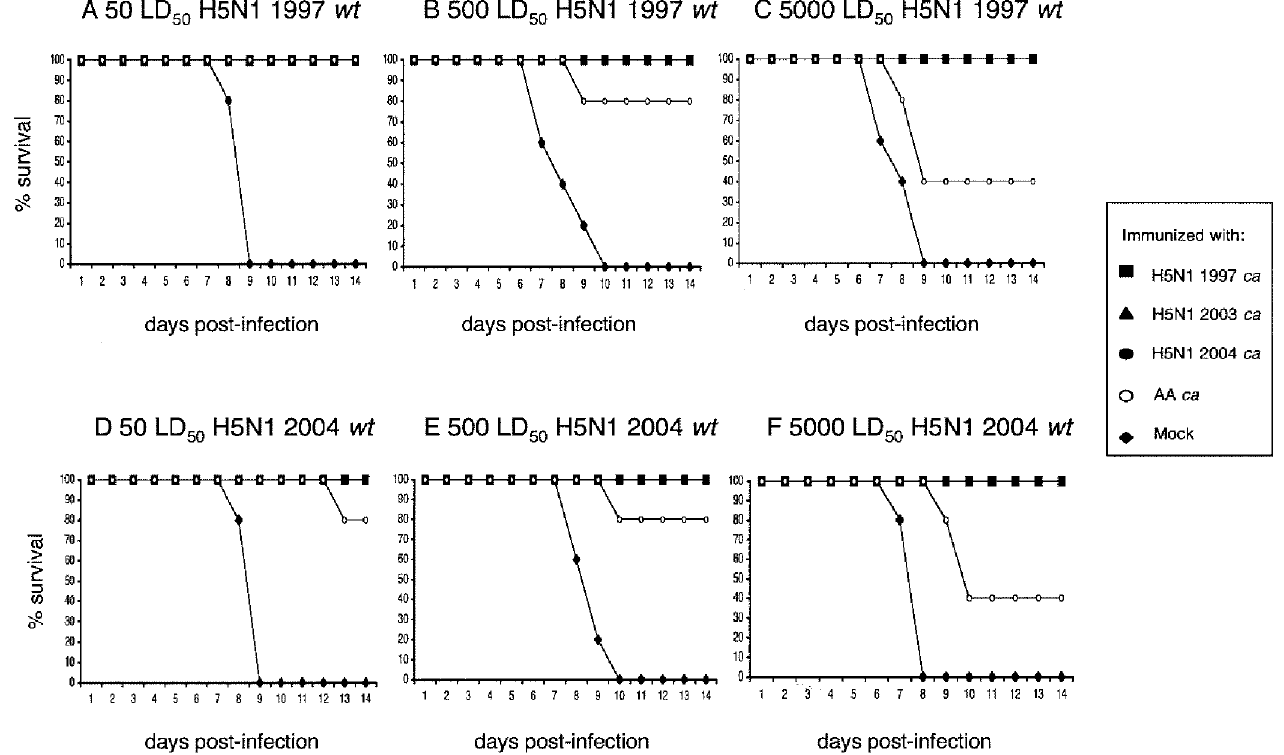
Figure 2. Survival of Mice Immunized with a Single Dose of H5N1 ca Vaccine Candidates Following Lethal Challenge with H5N1 1997 wt or H5N1 2004 wt Viruses Groups of eight mice that received a single dose of 10 6 TCID 50 of the H5N1 1997 ca ( & ), H5N1 2003 ca ( m ), H5N1 2004 ca ( n ), or AA ca ( ** ) viruses, or were mock-immunized (L-15 medium; ¤ ) were challenged with the H5N1 1997 wt (A–C) or H5N1 2004 wt virus (D–F) at 50 (A and D), 500 (B and E), or 5,000 (C and F) LD 50 . The mice were monitored daily for 21 d p.i. Immunization with the H5N1 1997 ca, H5N1 2003 ca, and H5N1 2004 ca viruses resulted in 100% survival of the mice following challenge, so the symbols for these groups are superimposed. DOI: